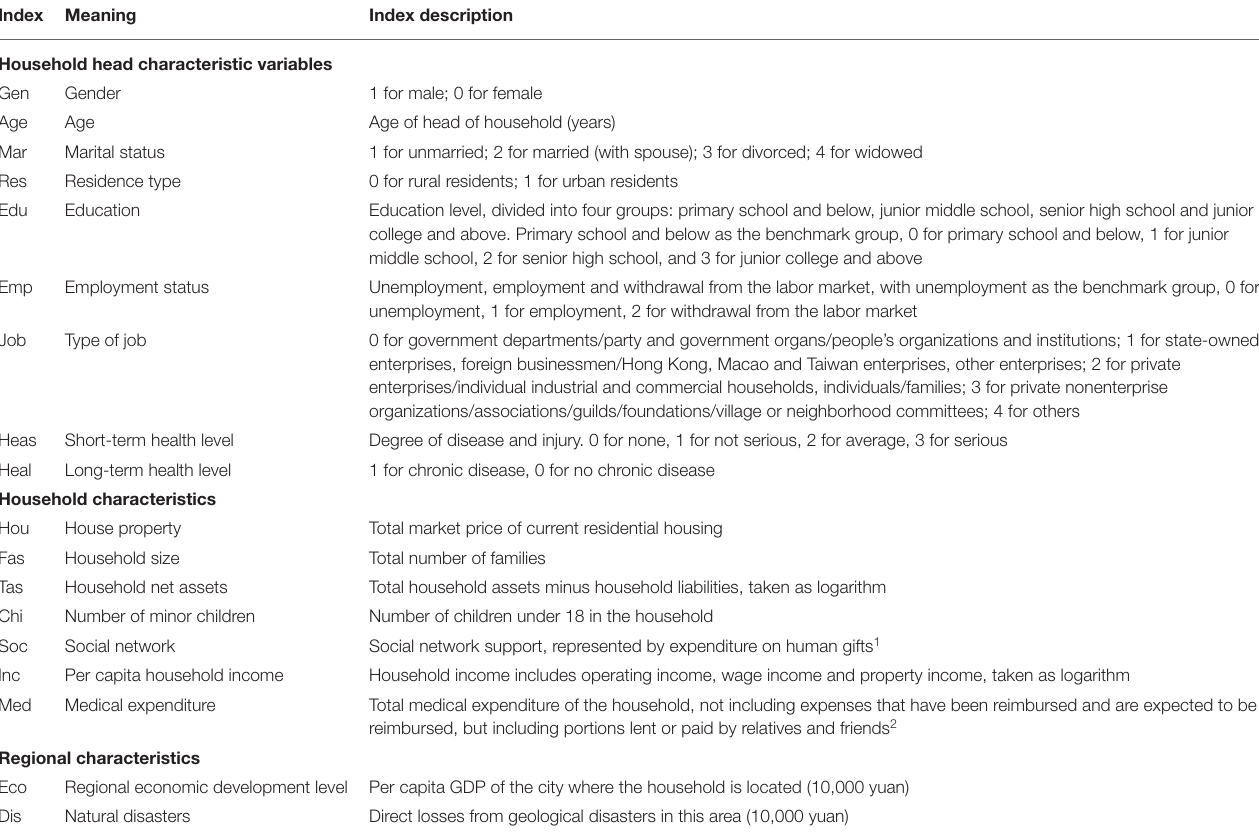
TABLE 1 | Indicators of vulnerability to